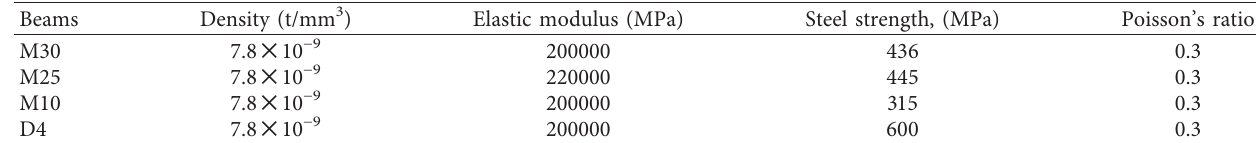
Table 2: Reinforcement material